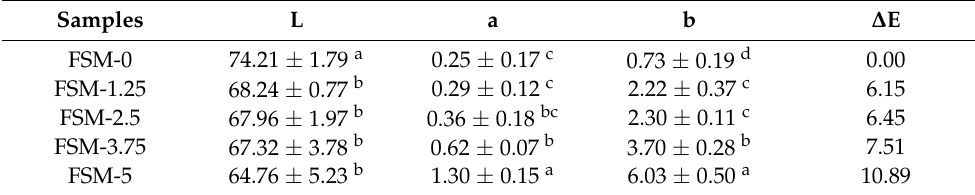
Table 1. Effect of MAA concentrations on the chroma value of composite films.